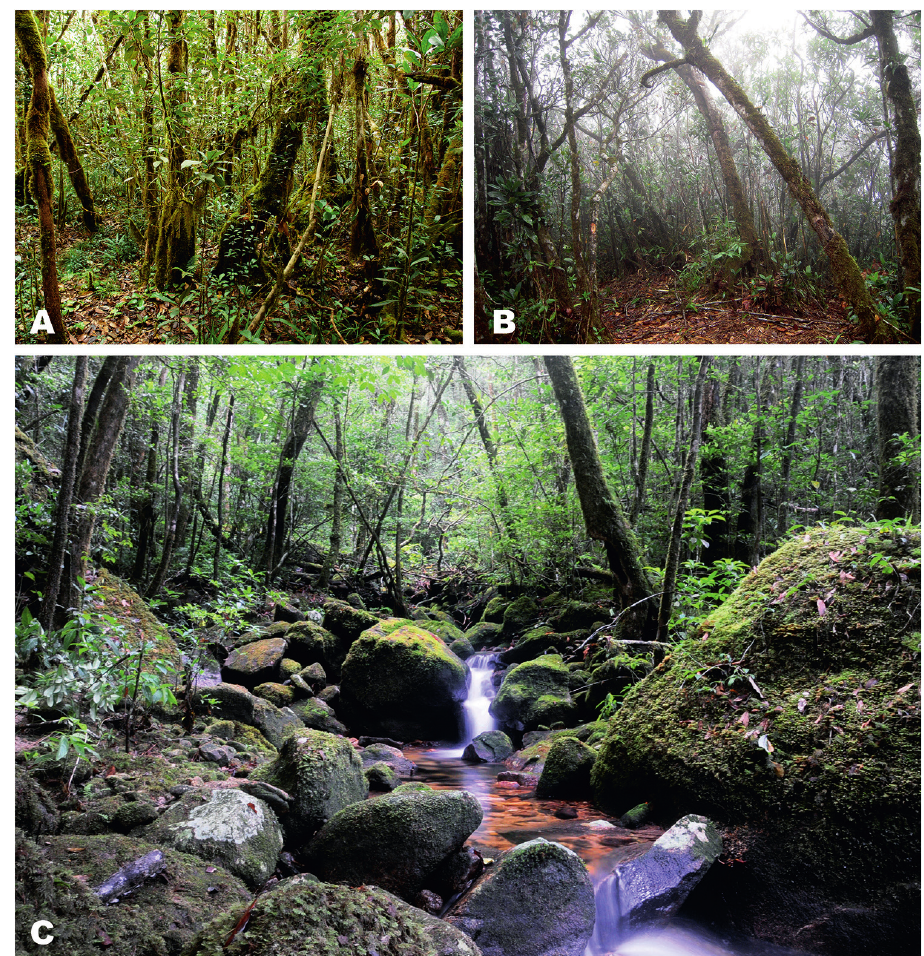
Figure 15. Natural habitat of Ophryophryne elfina sp. n. on Langbian Plateau, southern Vietnam. A Elfin forest on the top of Bidoup Mountain (ca. 2100 m a.s.l.), Bidoup–Nui Ba N.P., Lam Dong Prov. B elfin forest on the top of Hon Giao Mountain (ca. 2000 m a.s.l.), Bidoup–Nui Ba N.P., border of Lam Dong and Khanh Hoa provinces C typical breeding site along a mountain stream in an evergreen mixed sub- tropical montane forest on northern slopes of the Chu Pan Fan Mountain, Chu Yang Sin N.P., Dak Lak Prov. (type locality) (ca. 1900 m a.s.l.). Photos by N.A. Poyarkov and O.V. Morozova. Ophryophryne elfina sp. n. differs from allopatric O. microstoma (Guangxi and Yun- nan Provs., southern China to northern Vietnam, and northern Thailand; Khonsue and Thirakhupt 2001, Chan-ard 2003, Fei et al. 2009, 2010, 2012, Nguyen et al. 2009), by much smaller adult size: Ophryophryne elfina sp. n. male SVL 26.9–33.9 mm, N = 29, female SVL 35.1–36.5 mm, N = 6 (vs. O. microstoma male SVL 34.3–44.4 mm, N = 10, female SVL 39.4–57.0 mm, N = 7; Ohler 2003, Fei et al. 2009, Stuart et al. 2010; our data), short anterior dorsolateral glandular ridge above each shoulder